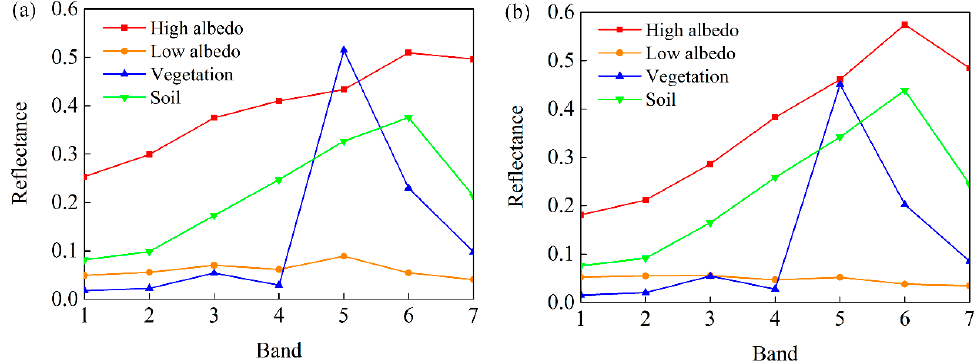
Figure 7. Spectral curves of endmember selection of the conventional ( a ); and modified ( b ) LSMA methods.